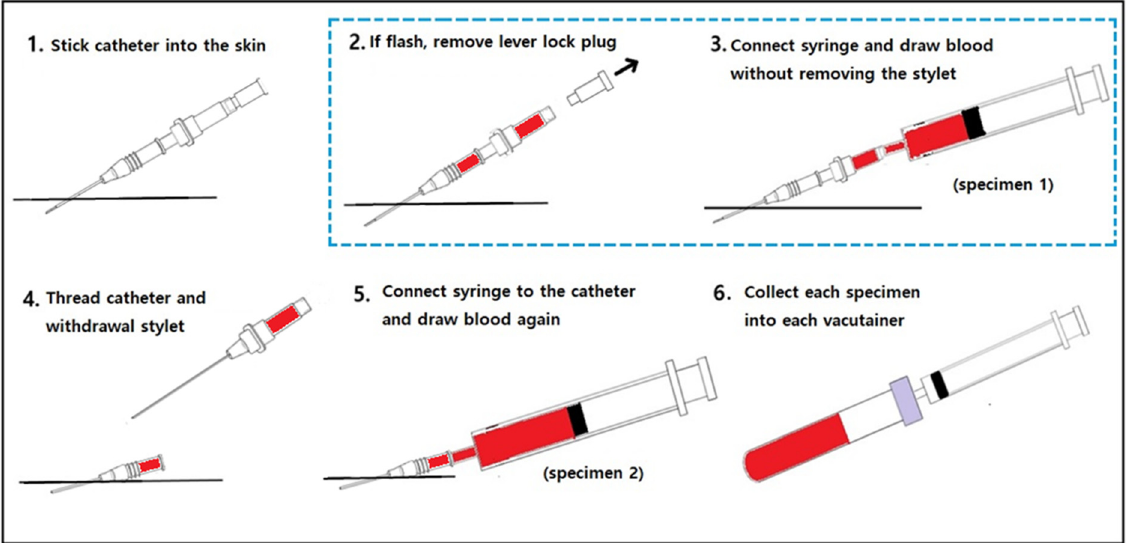
Figure 2. The blood sampling protocol in this study: the new blood collection method (2, 3) and the conventional blood sampling (4, 5) method.